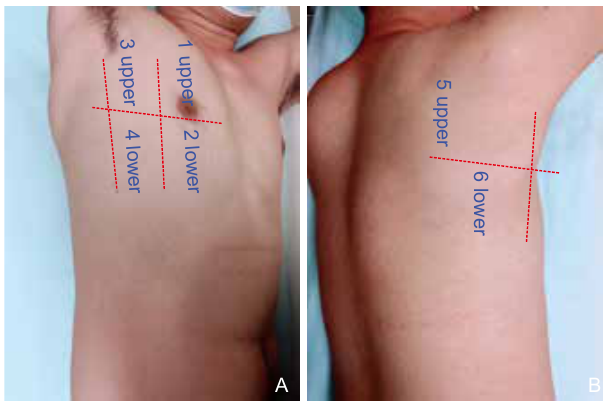
Figure 1 Partitioning method for one-sided six-zone scheme. (A and B) Supine or lateral position (right side), divided by anterior axillary line and posterior axillary line, are divided into three regions of anterior lung, lateral lung, and posterior lung, each of which is further divided into upper and lower parts.